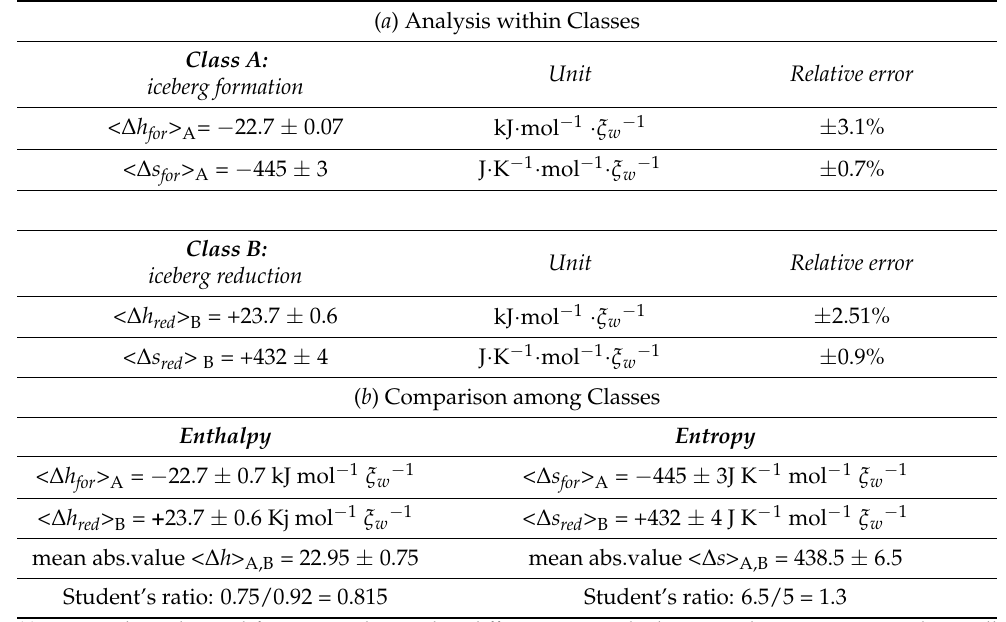
Table A2. Validation of the Ergodic Algorithmic Model ( EAM ). For analysis of unitary thermody- namic functions (*), see reference